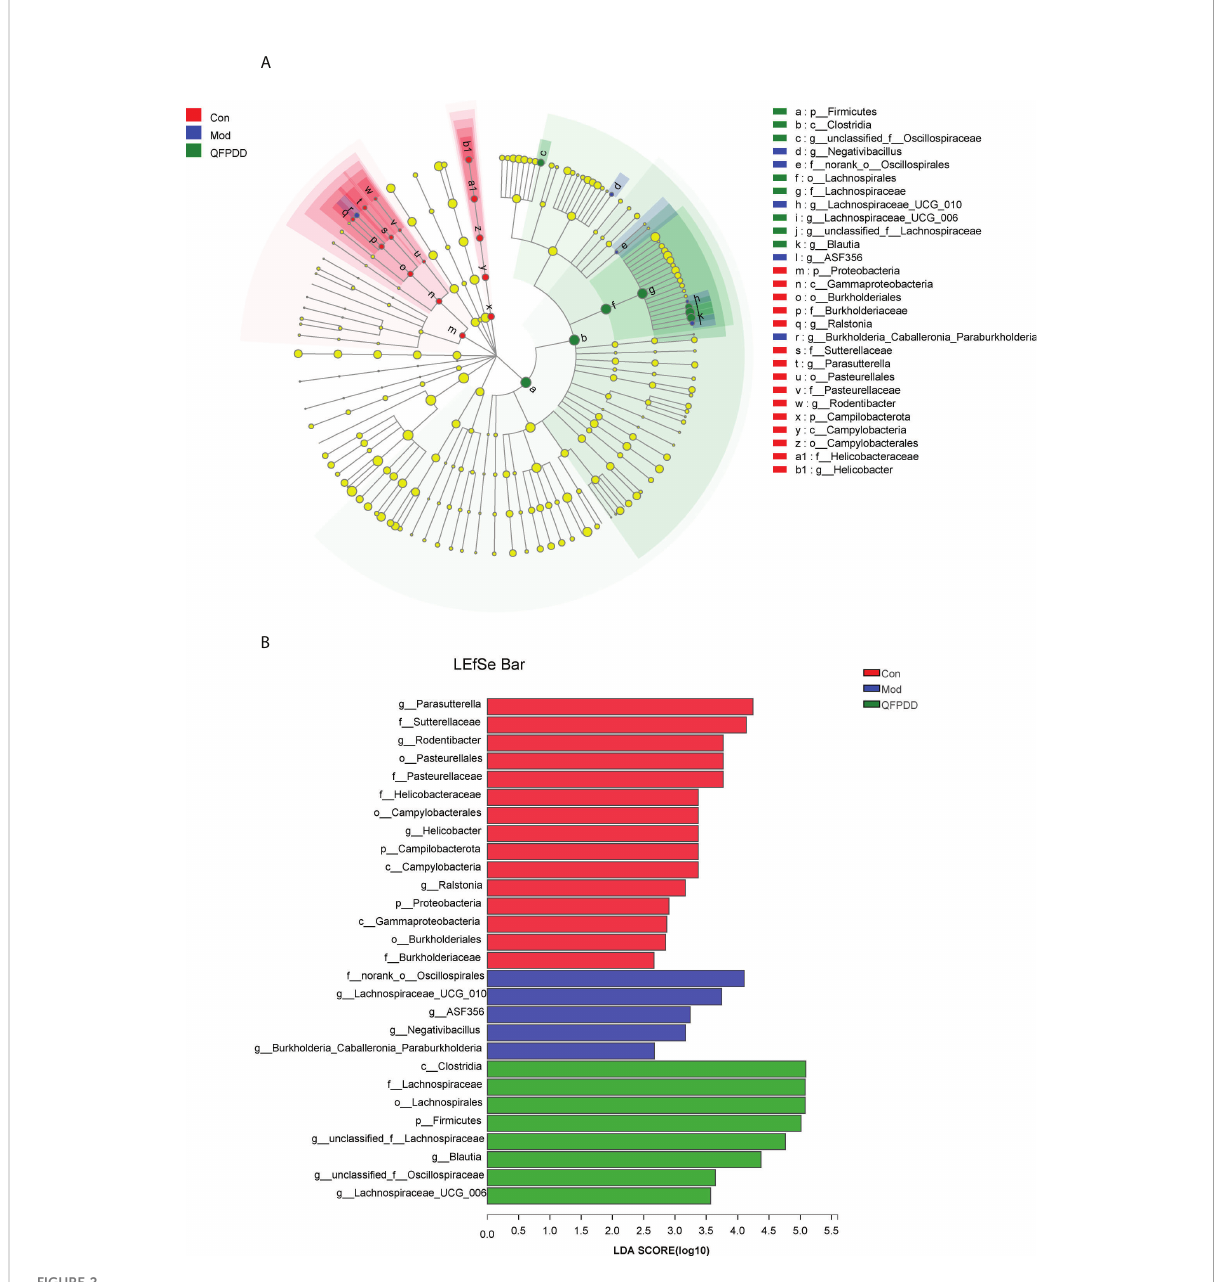
FIGURE 2 Linear discriminant analysis (LDA) integrated with effect size (LEFSe). (A) Cladogram indicating the phylogenetic distribution of microbiota correlated with the Con, Mod, and QFPDD groups. (B) The differences in abundance between the Con, Mod, and QFPDD